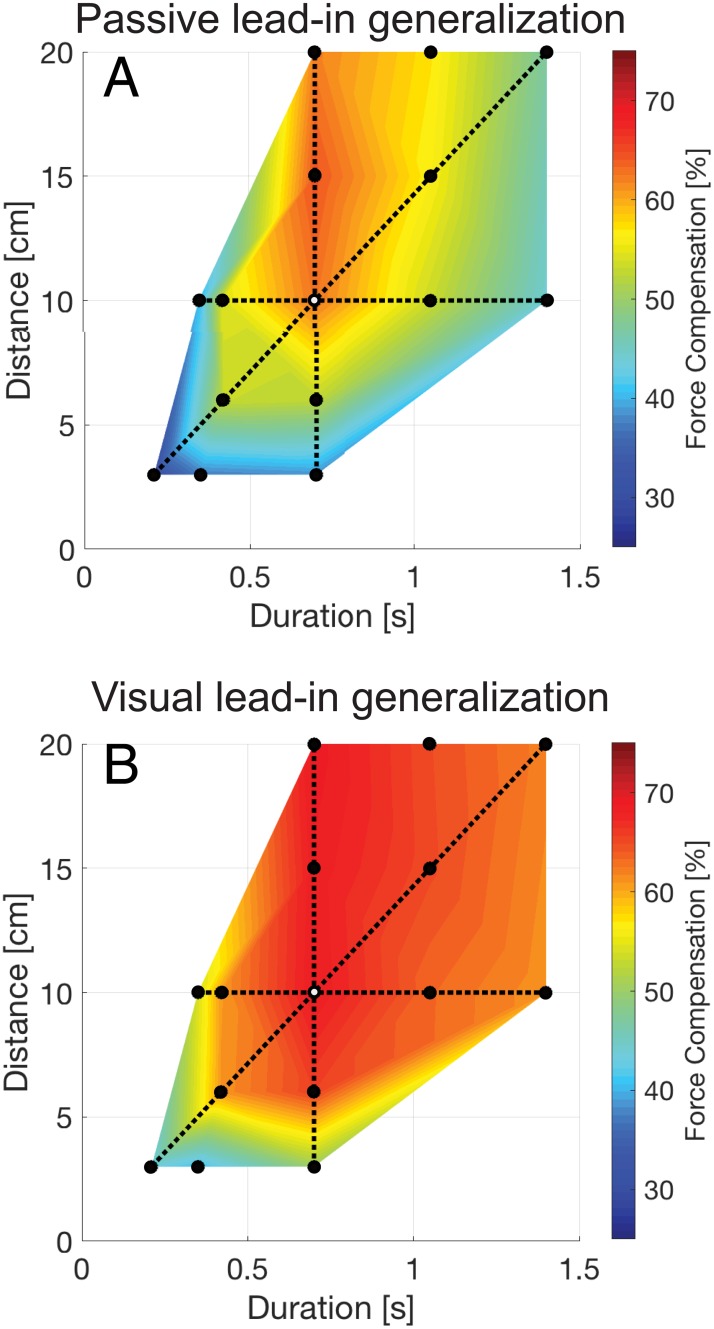
Generalization surface plots for passive and visual lead-in movements.A Surface plot of generalization for passive lead-in movements. The percentage force compensation is represented by color and plotted against lead-in duration and lead-in distance. The black circle with a white center indicates the result at the training condition. The solid black dots indicate points for which measurements were made on probe trials. The black dotted lines correspond to conditions with the same training lead-in distance of 10 cm, same training lead-in duration of 0.7s or same training lead-in speed of 26.8 cm/s. The legend shows the correspondence between color and percentage perfect force compensation. B Surface plot of generalization for the visual lead-in condition.